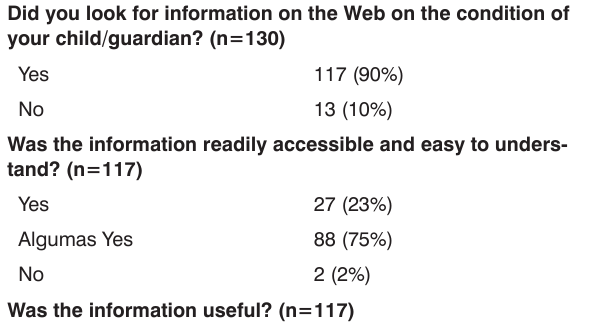
Table 2. Questionnaire - searching for disease information on the Web